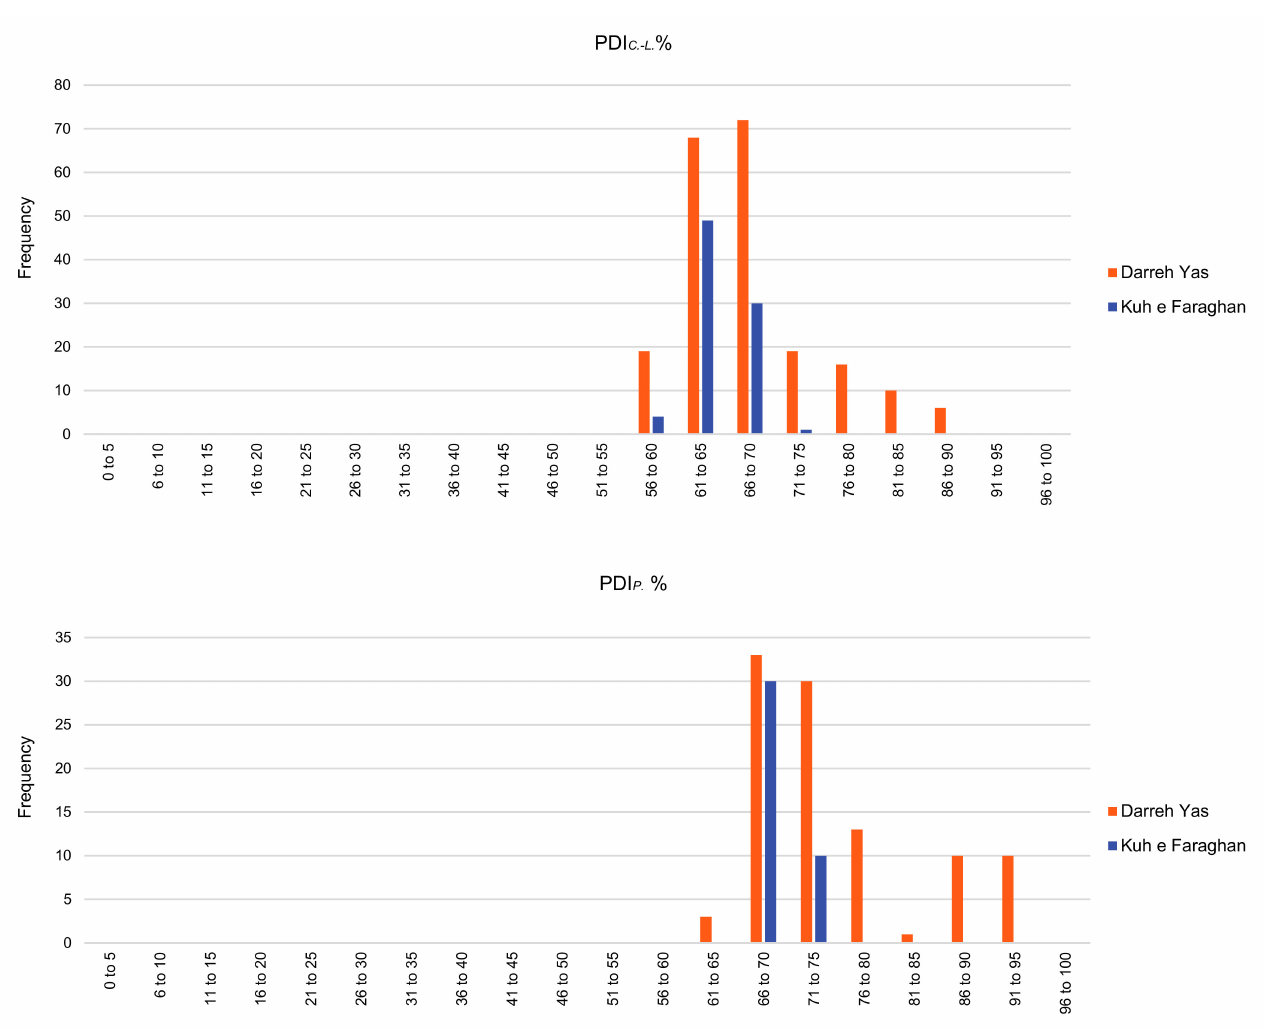
Figure 7. Histograms of PDI C.-L % . ( Calamospora - Laevigatosporites ) and PDI P. % ( Punctatisporites ) of the Faraghan Formation at the Darreh Yas and Kuh e Faraghan